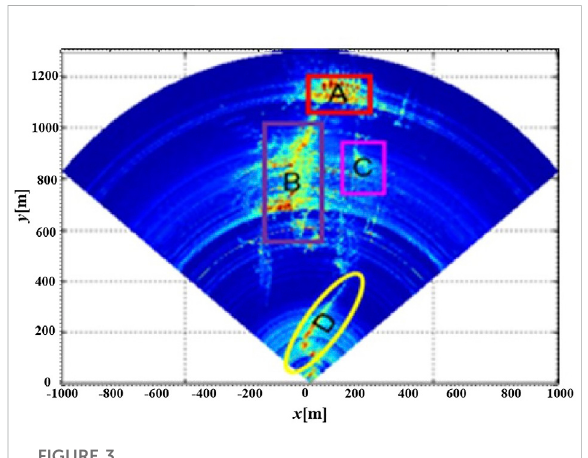
FIGURE 4 GB-SAR monitoring equipment layout